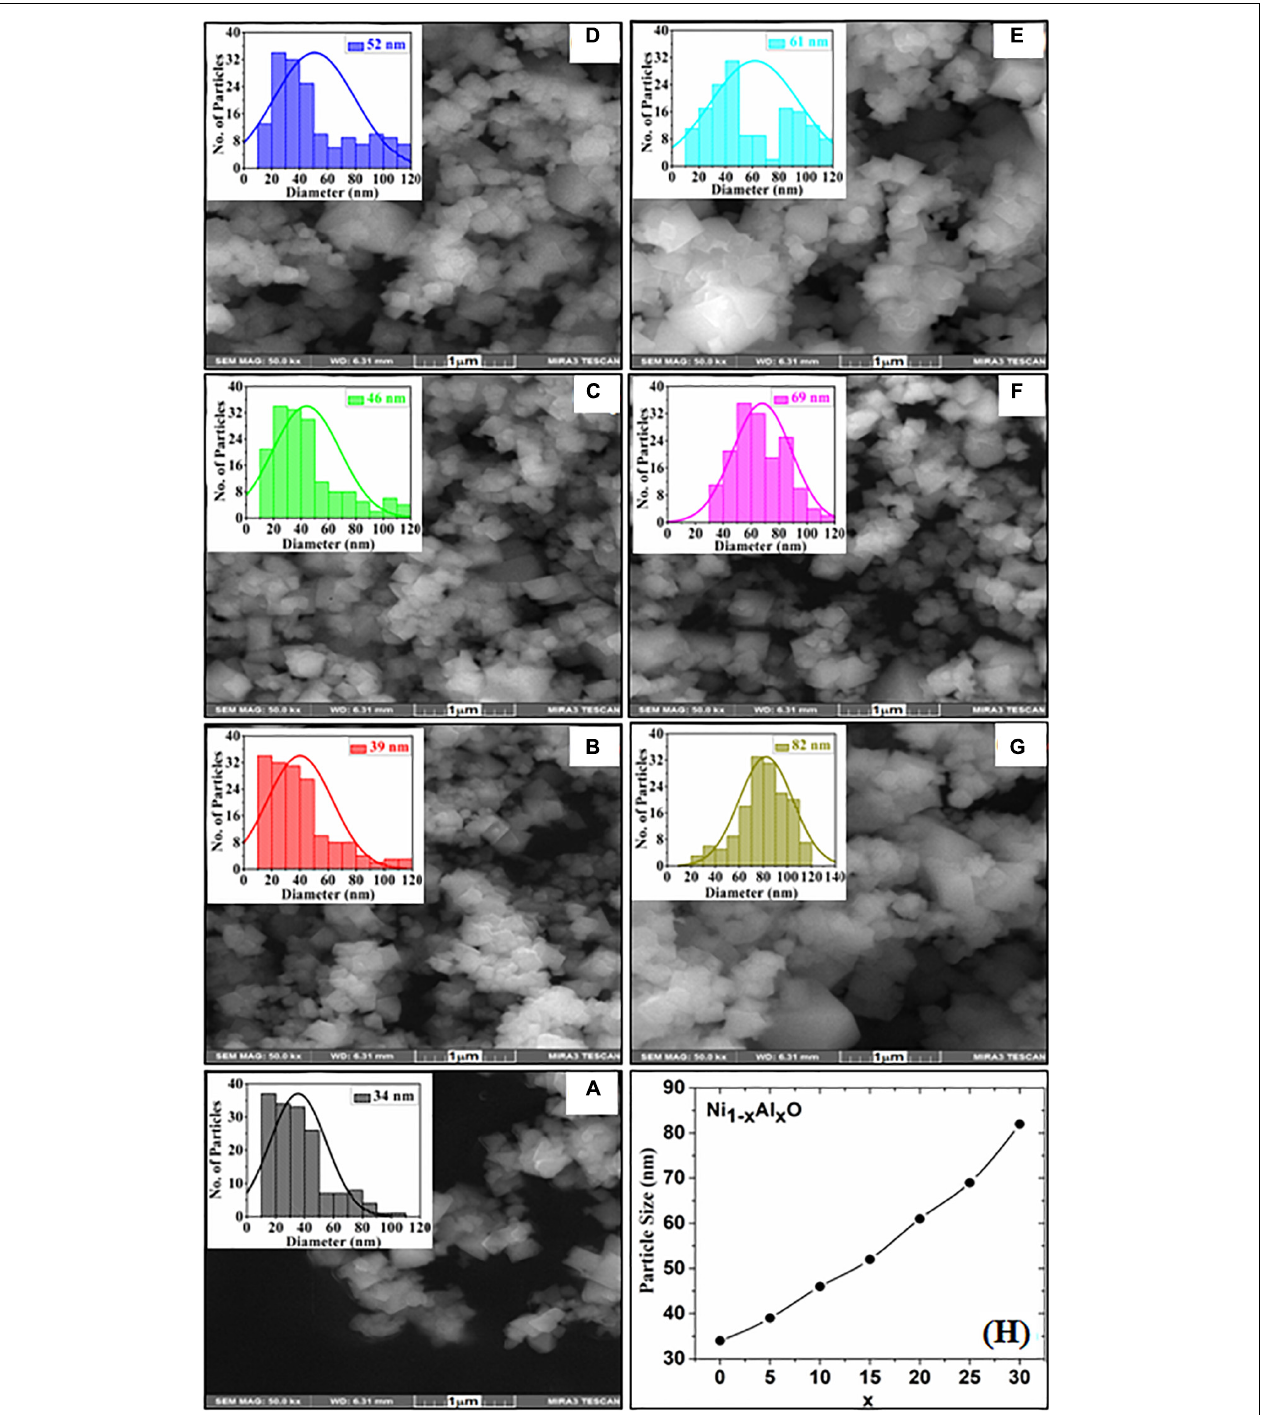
FIGURE 2 | (A–G) SEM images with inset histograms of Ni 1 − x Al x O; x = 0, 5, 10, 15, 20, 25, and 30 wt.% nanoparticles, respectively, (H) Variation of particles size verses Al contents (x).